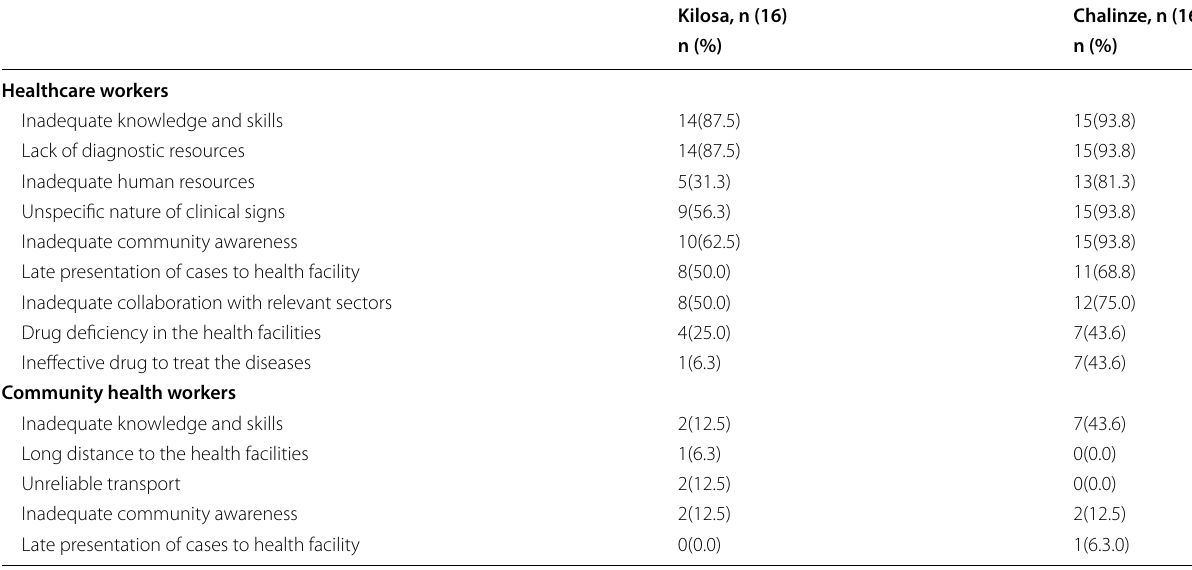
Table 4 Challenges regarding detection and reporting of brucellosis in Kilosa and Chalinze